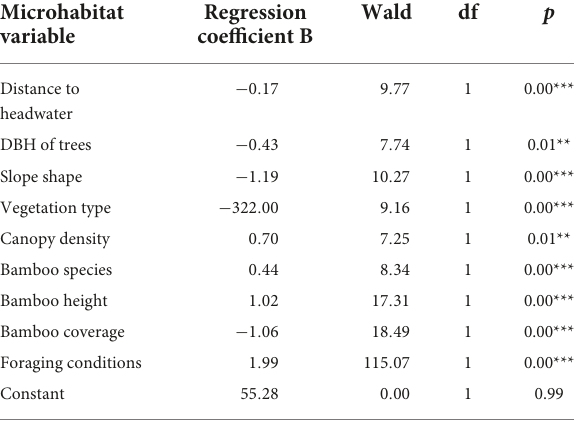
TABLE 4 Logistic regression analysis between giant panda habitat selection plots and control